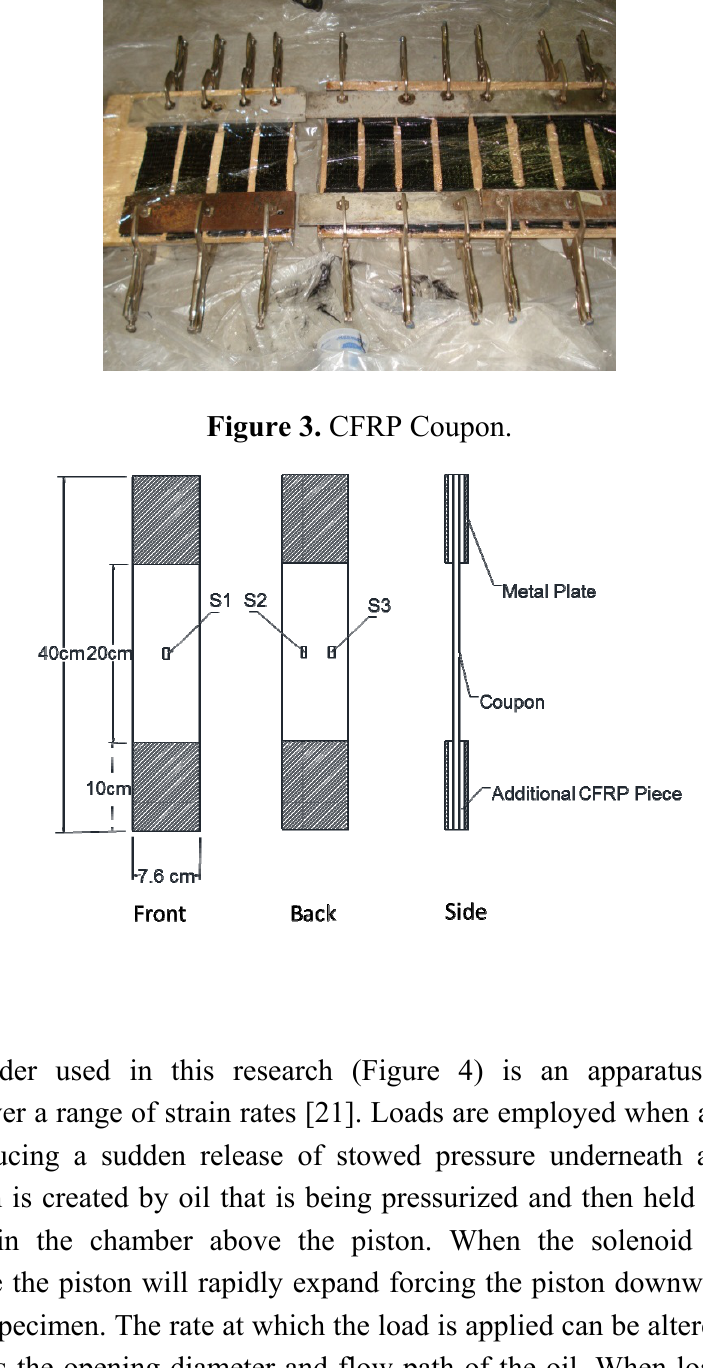
Figure 2. Carbon fiber reinforced polymer ( CFRP) Laminates during Wet-layup Curing.